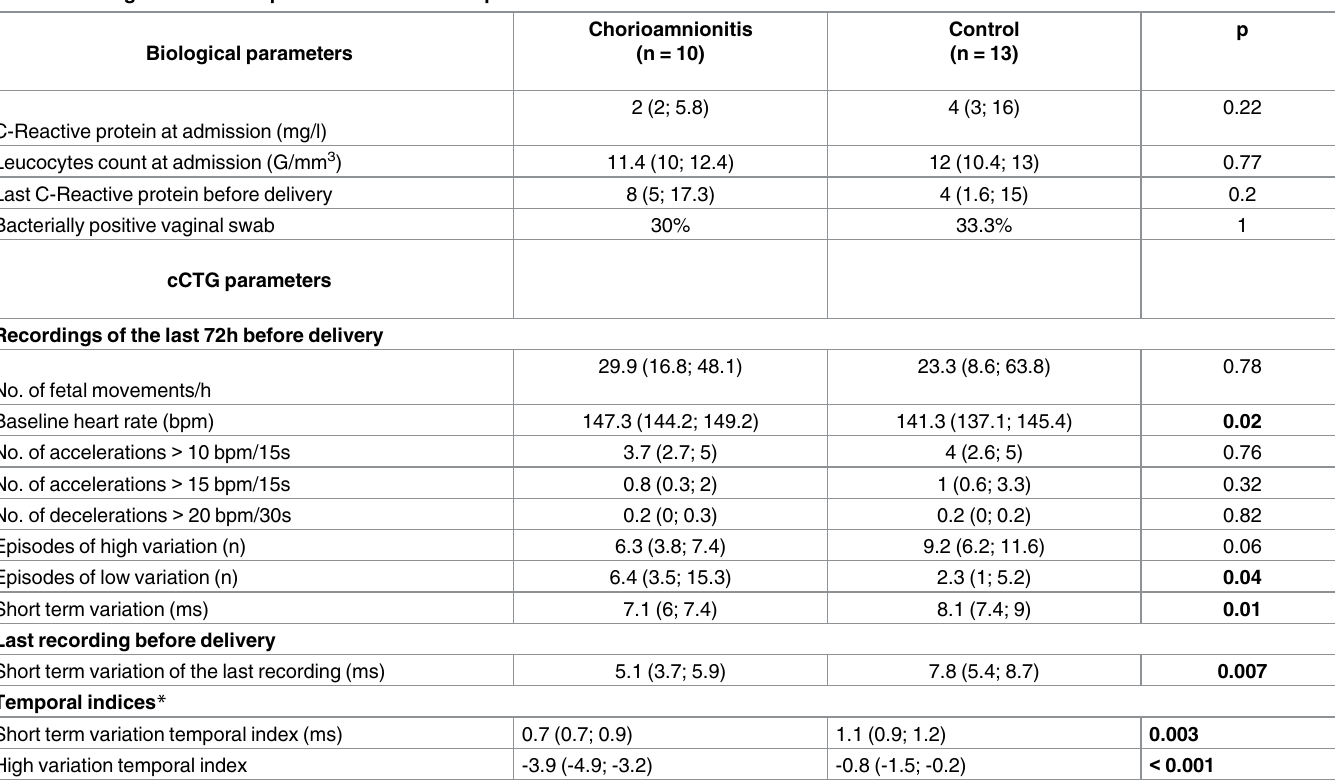
Table 2. Biological and cCTG parameters in cases of pPROM with or without HC. Biological